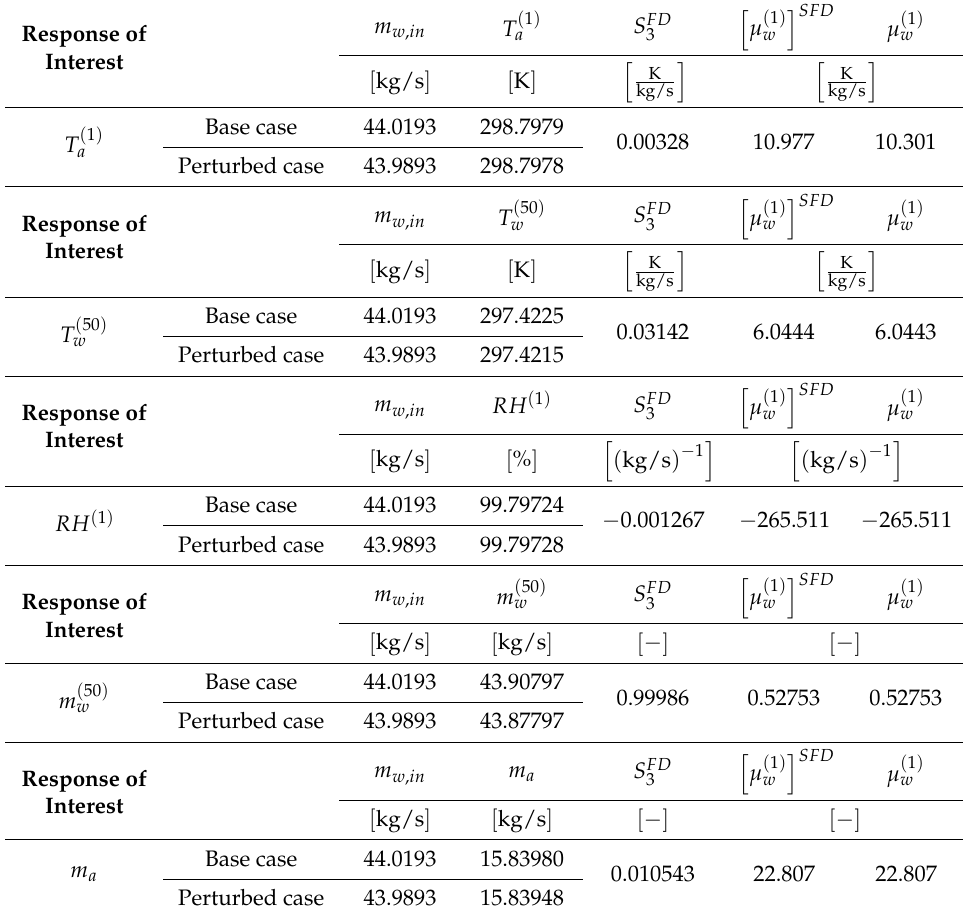
Table E5. Verification Table for adjoint function µ ( 50 ) m w and m a